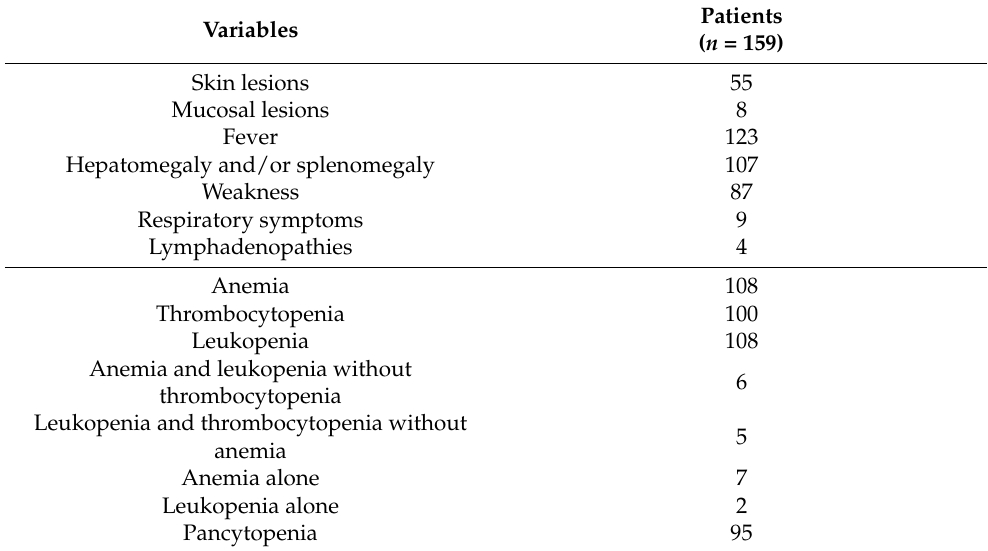
Table 3. Summary of the symptoms and laboratory findings of the case reports and case series of Leishmania infection after kidney transplantation (summaries based on individual cases should not be considered as an estimate of the “real